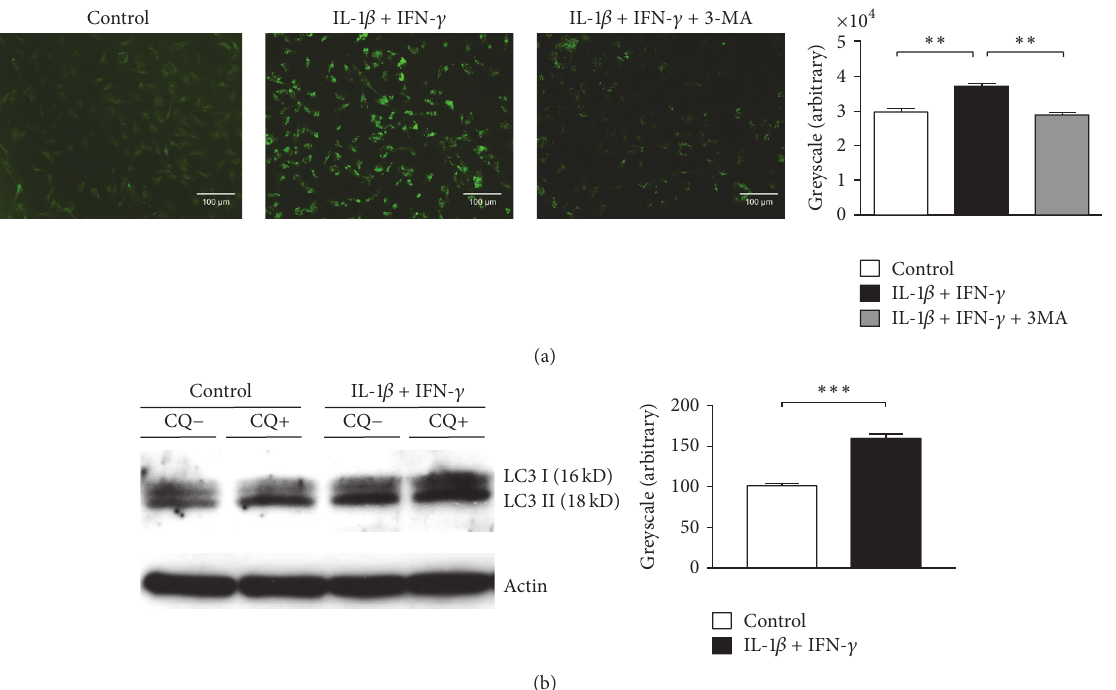
Figure 1: IL-1 𝛽 and IFN- 𝛾 induced autophagy. (a) Immunofluorescence analysis revealed IL-1 𝛽 and IFN- 𝛾 induced accumulation of autophagosomes in GFP-LC3-transfected rhabdomyosarcoma cells. Inhibition of autophagy was exerted by 3-MA treatment. Quantitative greyscale analysis of LC3 fluorescence intensity of cells incubated with IL-1 𝛽 and IFN- 𝛾 was carried out using Image J software. Results are calculated as mean of three independent experiments and statistical significance is indicated by ∗∗ 𝑝 < 0.01 . (b) Western blotting: autophagosome-associated LC3-II and free cytosolic LC3-I were distinguished by molecular weight (16 and 18kDa, resp.). 48 hours exposure of human rhabdomyosarcoma cells to IL-1 𝛽 and IFN- 𝛾 led to increased levels of LC3-II. One of three independent experiments with identical results is shown. Greyscale analysis of the LC3-II signal was carried out using Image J software and results are shown as mean plus standard error from three independent experiments. Statistical significance is indicated by ∗∗∗ 𝑝 < 0.001